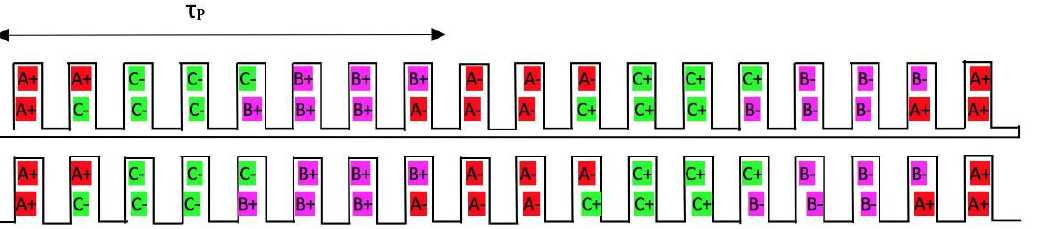
Figure 18. Double-layer winding configuration with short pitch equal to 8.